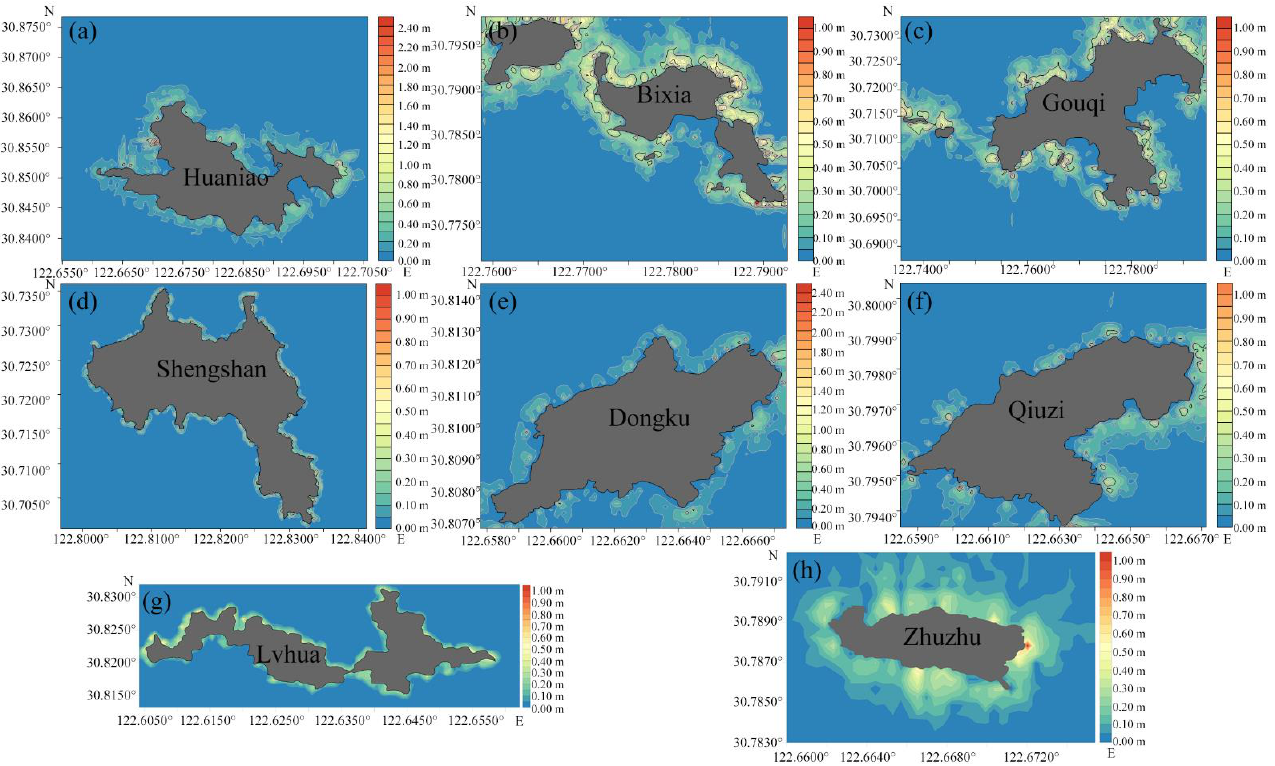
Figure 3. Height distributions of seaweed in the Ma’an Archipelago. ( a ) HN (Huaniao), ( b ) BX (Bixia), ( c ) GQ (Gouqi), ( d ) SS (Shengshan), ( e ) DK (Dongku), ( f ) QZ (Qiuzi), ( g ) LH (Lvhua), and ( h ) ZZ (Zhuzhu).